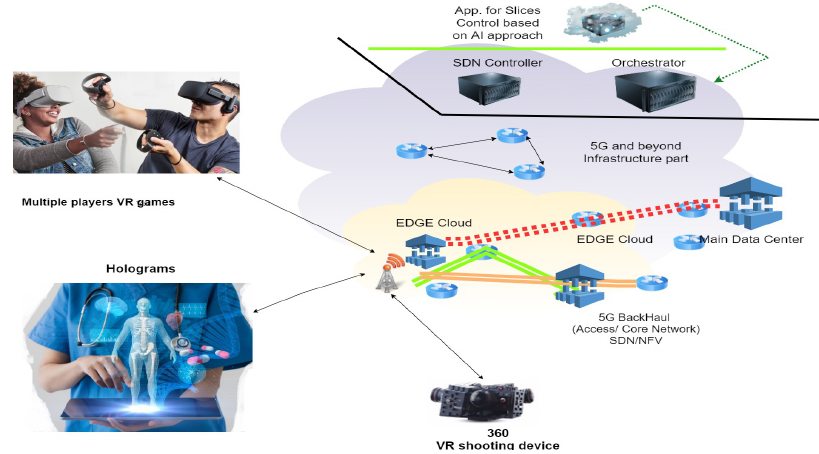
Figure 1. Intelligent core network based on mobile edge computing (MEC) servers with multiple